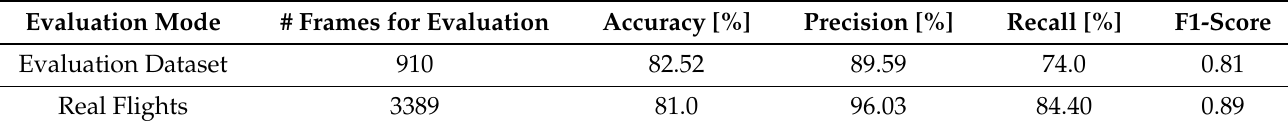
Table 1. Metric evaluation comparison of the CNN loaded into the OAK-D camera. The first row corresponds to the evaluation of the trained model using an evaluation dataset extracted from the image dataset described in Section 3.3. The second row shows the evaluation using frames recorded during three flights selected randomly out of the ten flights in the real scenario.